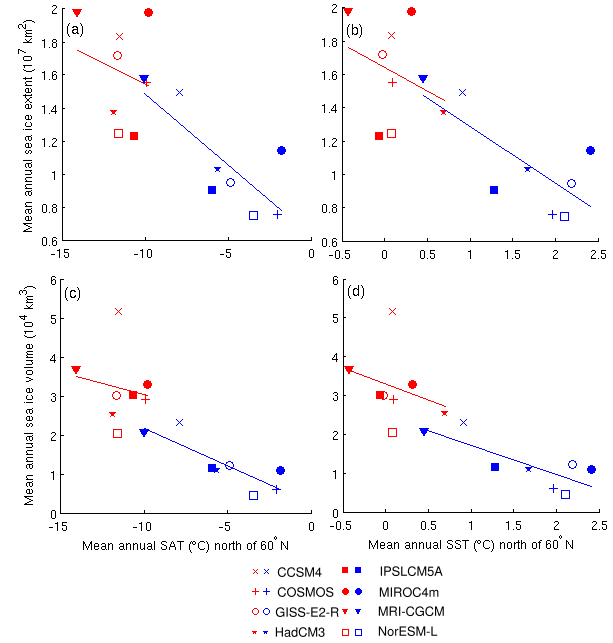
Figure 10. Mean annual surface temperatures north of 60 ◦ N vs. mean annual total Arctic sea ice extent (a, b) , and mean annual sur- face temperatures north of 60 ◦ N vs. mean annual total Arctic sea ice volume (c, d) in both pre-industrial and mid-Pliocene simula- tions for (a, c) SAT and (b, d) SST. Pre-industrial experiments are marked red, mid-Pliocene experiments are marked in blue. Corre- lation coefficients for the pre-industrial simulations in each plot are (a) − 0.18, (b) − 0.26, (c) − 0.12, and (d) − 0.29. Correlation coeffi- cients for the mid-Pliocene simulations in each plot are (a) − 0.76, (b) − 0.73, (c) − 0.83, and (d) − 0.82. Only correlations greater than 0.70 are significant at the 95% level. Figure 11. Location of Ocean Drilling Program (ODP) sites 911A